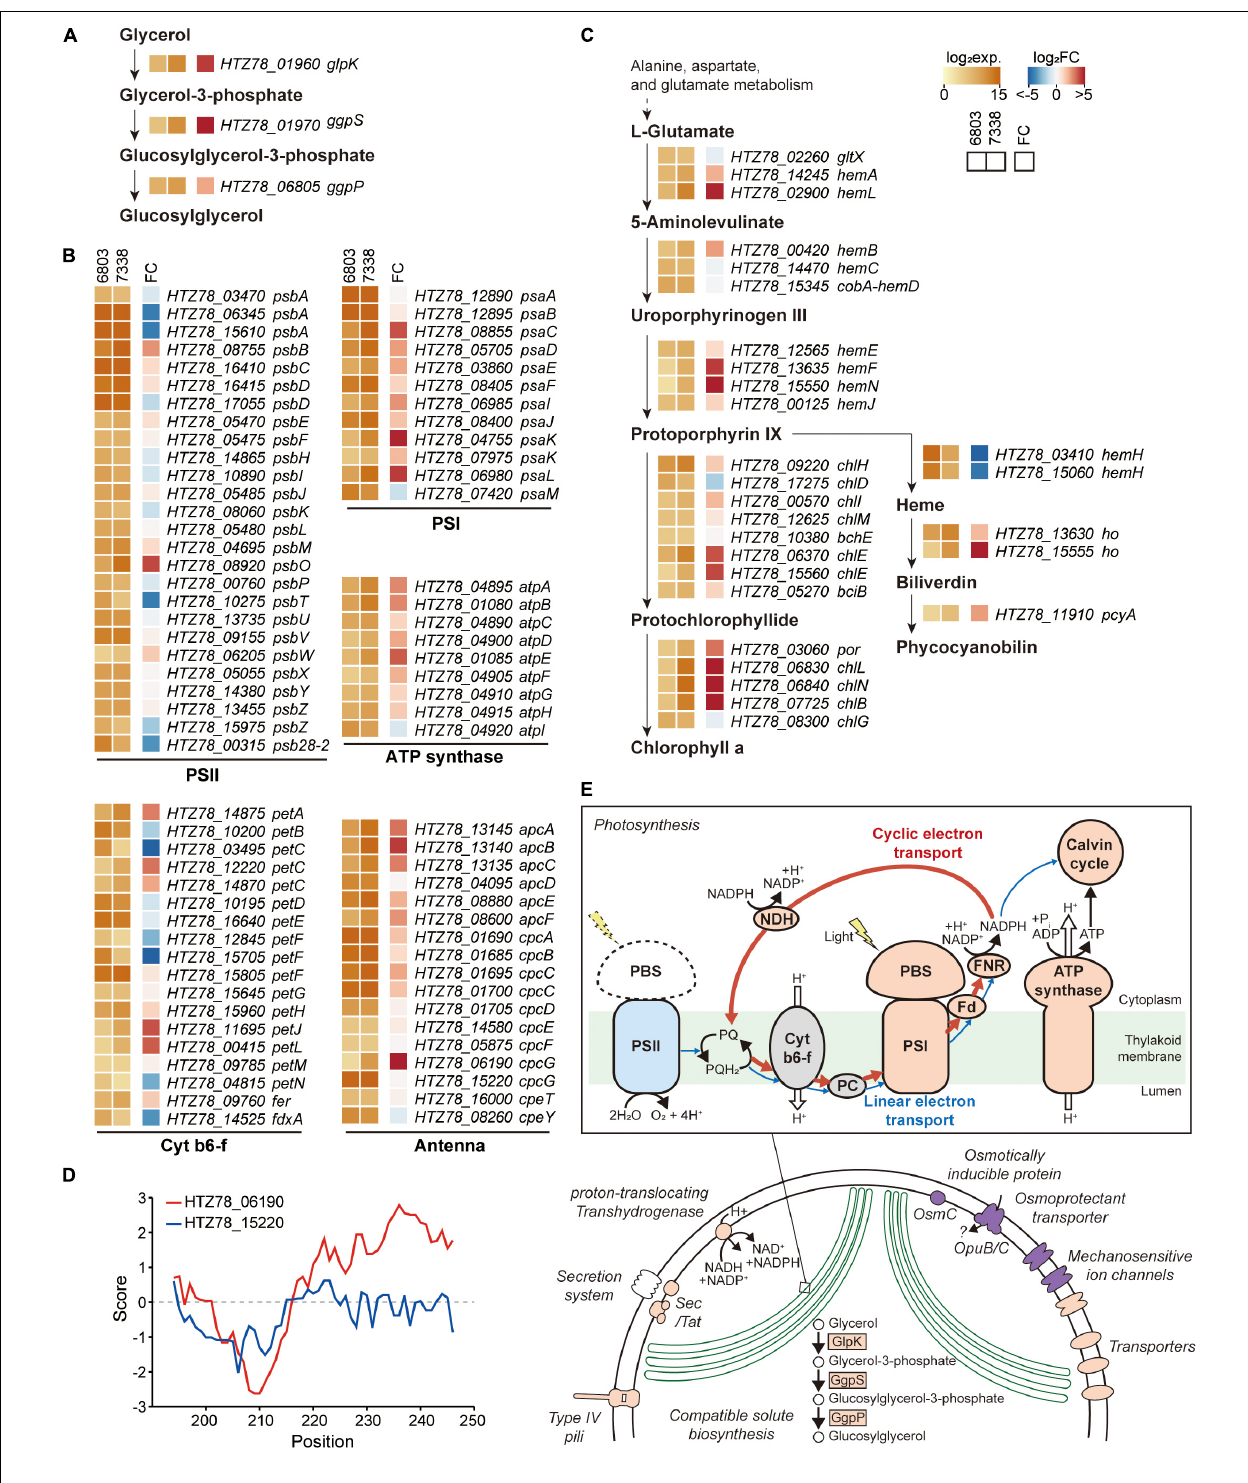
FIGURE 4 | Messenger RNA (mRNA) expressions in Synechocystis sp. PCC 7338. (A–C) Log 2 mRNA expression levels and log 2 fold changes of orthologs in Synechocystis sp. PCC 7338 compared to those of Synechocystis sp. PCC 6803. The orthologs related to glucosylglycerol biosynthesis (A ), photosynthesis including photosystem II (PSII), cytochrome b6-f (cyt b6-f), photosystem I (PSI), ATP synthase, and antenna proteins (B) , and porphyrin and chlorophyll metabolism pathway (C) were described. (D) Hydrophobicity calculated at the C-terminal of 2 cpcG in Synechocystis sp. PCC 7338. (E) Schematic illustration of proposed response in Synechocystis sp. PCC 7338. Orange color indicates the upregulation of the component compared to Synechocystis sp. PCC 6803, and blue color indicates the downregulation. Purple color indicates the specific component that is exclusively present in Synechocystis sp. PCC 7338.